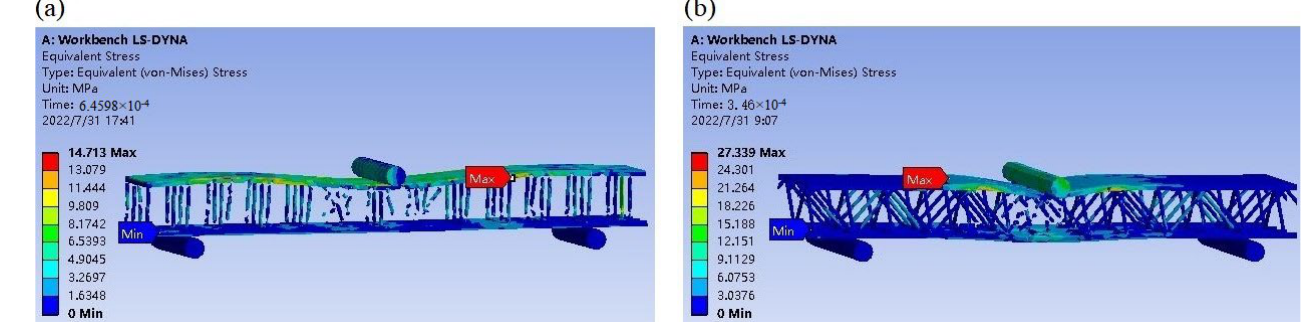
rods in the slotted Warren truss (b) resin stiffener structure remained intact at the maximum groove, and cylindrical deep hole (a) resin stiffener structures were mostly broken. ken.